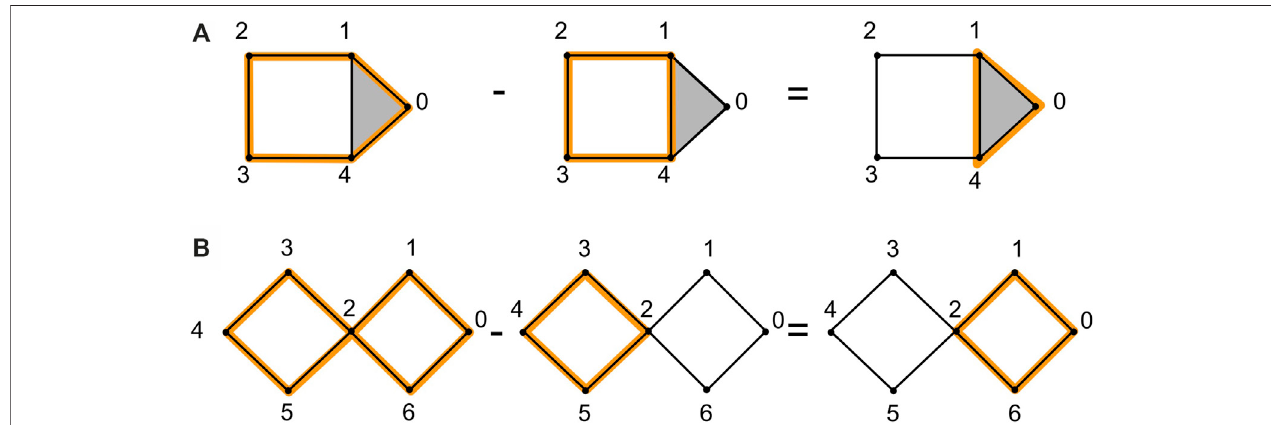
FIGURE 2 | We show an example of homologous cycles in (A) , adapted from (Topaz et al., 2015). The 1-cycle ( 0 , 1 ) + ( 1 , 2 ) + ( 2 , 3 ) + ( 3 , 4 ) − ( 0 , 4 ) and the 1- cycle ( 1 , 2 ) + ( 2 , 3 ) + ( 3 , 4 ) − ( 4 , 1 ) are homologous because their difference is the boundary of ( 0 , 1 , 4 ) . Sub fi gure (B) shows an example of non-homologous cycles. The 1-cycle ( (cid:7) 4 i (cid:2) 0 ( i , i + 1 )) − ( 5 , 2 ) + ( 2 , 6 ) − ( 0 , 6 ) and the 1-cycle ( 2 , 3 ) + ( 3 , 4 ) + ( 4 , 5 ) − ( 2 , 5 ) are not homologous because their difference is a cycle ( 0 , 1 ) + ( 1 , 2 ) + ( 2 , 6 ) − ( 0 , 6 ) which is not a linear combination of boundaries of